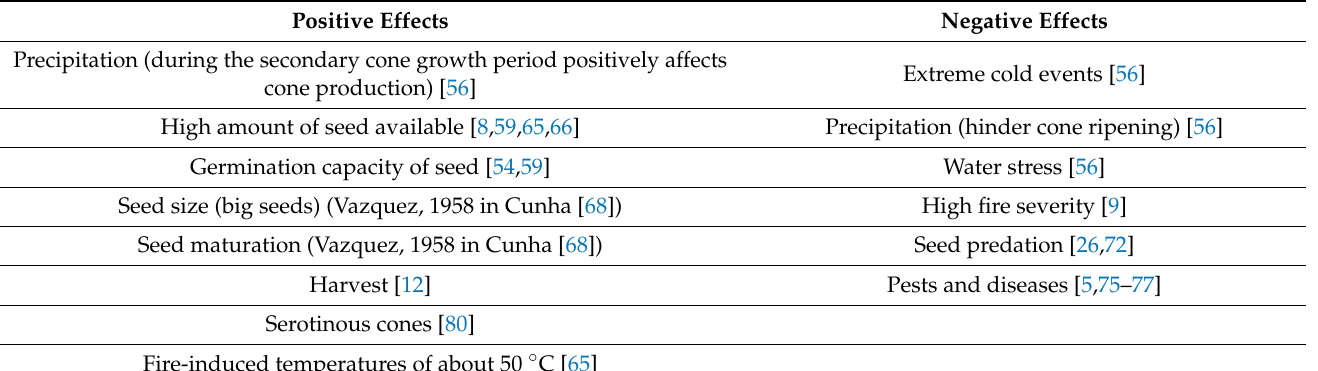
Table 1. Ecological factors influencing the natural regeneration of maritime pine. Phase: